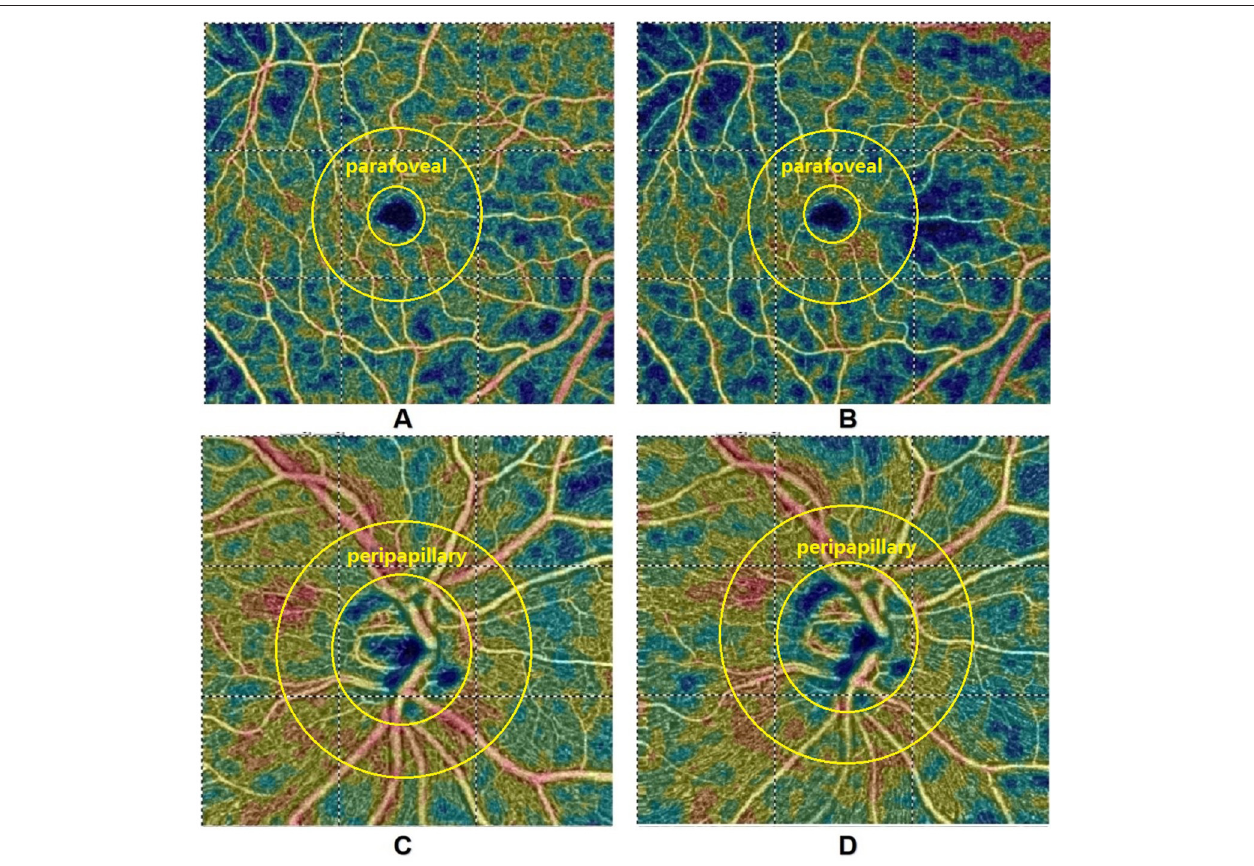
FIGURE 1 | Optical coherence tomography angiographic images of the parafoveal (A,B) and peripapillary (C,D) regions at baseline (A,C) and during Phase IV (B,D) of the Valsalva maneuver. Parafoveal and peripapillary retinal perfused vessel density decreased by 10.2 and 3.6%, respectively. Diastolic blood pressure and systolic blood pressure increased by 1.2 and 10.4%,